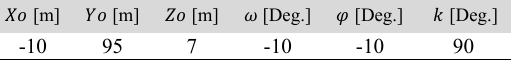
Table 9. GCP coordinates of the second test of a perspective